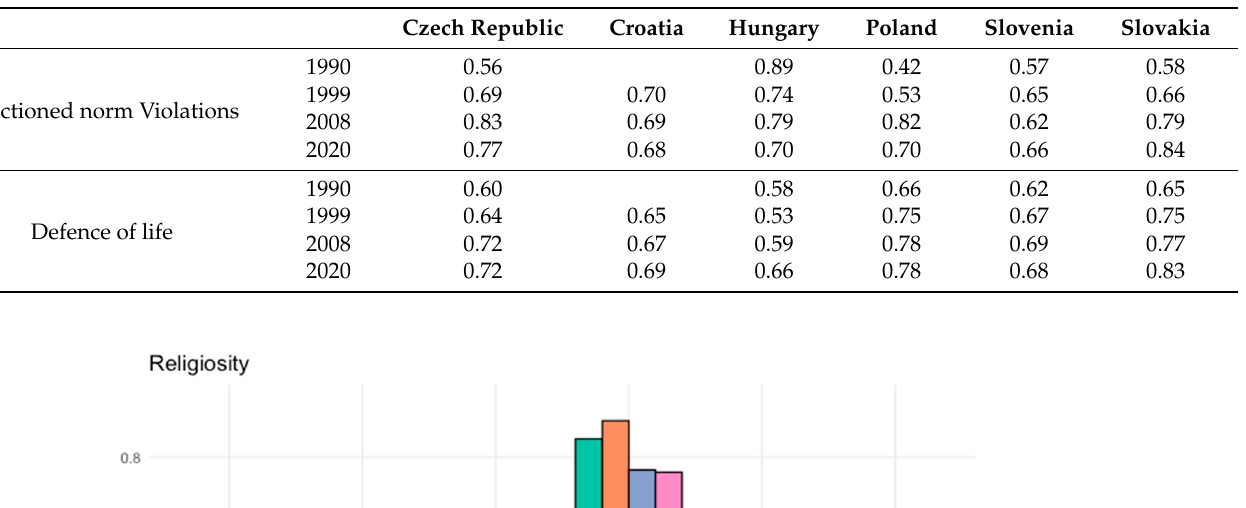
Table A1. Cronbach alpha values of indices.